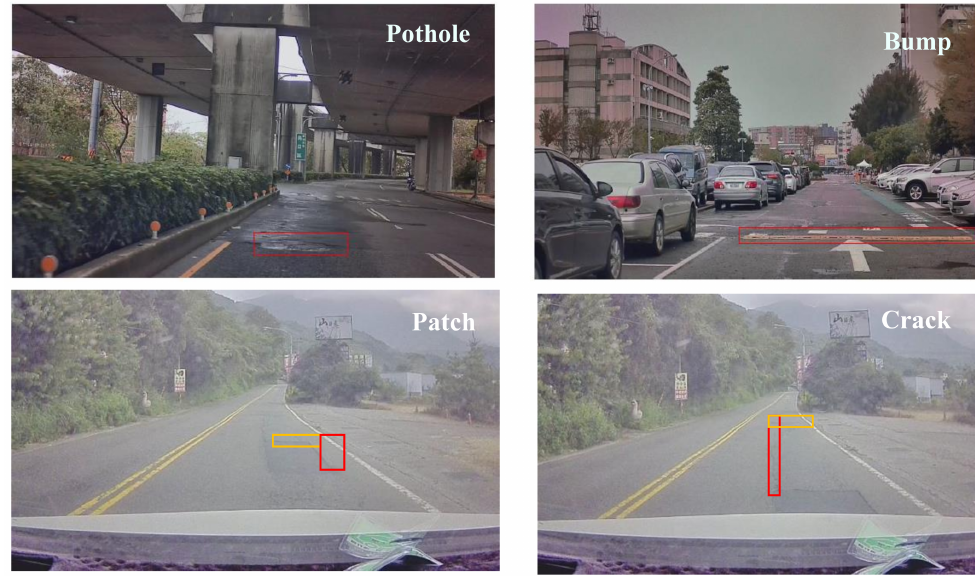
Figure 6. Taiwan pavement defect image database